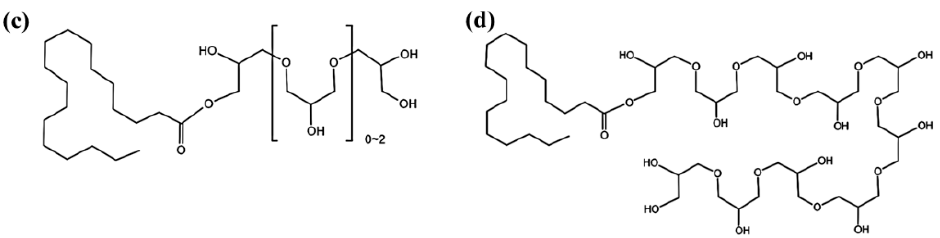
Figure A1. Molecular structure of different polyglycerol esters: ( a ) triglyceride monostearate (TMS), C27H54O8, molecular weight 506.71, hydrophilic and lipophilic balance 6.2; ( b ) triglyceride monolaurate (TML), C21H41O8, molecular weight 422.56, hydrophilic and lipophilic balance 8.5; ( c ) PGE55, C24H48O6–C30H60O10, molecular weight 432–580, hydrophilic and lipophilic balance 7; ( d ) polyglyceryl-10 monostearate (PMS), C48H95O22, molecular weight 1024.25, hydrophilic and lipophilic balance 11.3.